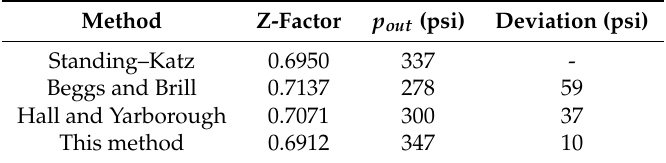
Table 2. Performance of the various methods on the prediction of the pipeline outlet pressure (Case Study 2).